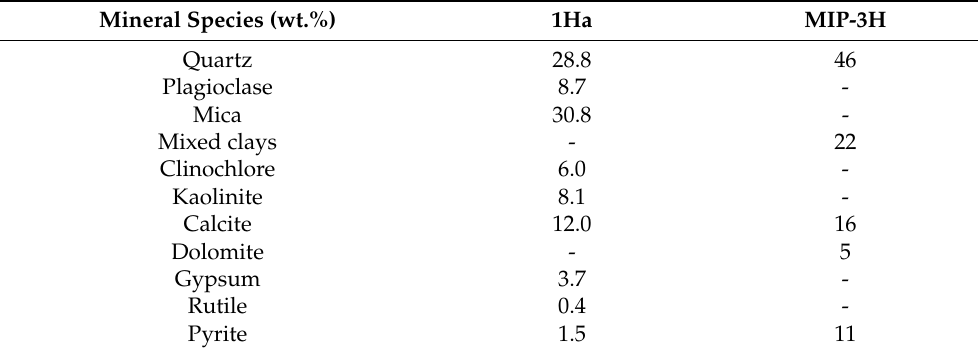
Figure 3. NASC-normalized whole-rock critical REY pattern. Table 2. Mineralogy of unreacted 1Ha sample determined by X-ray Diffraction analysis and MIP-3H from Pilewski et al., 2019